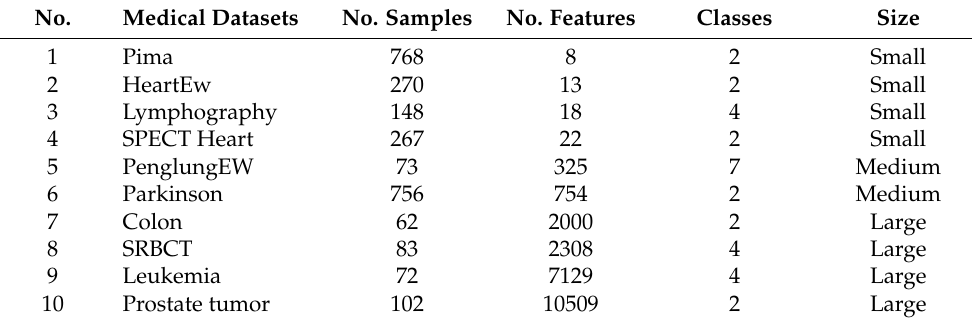
Table 3. Datasets specifications.